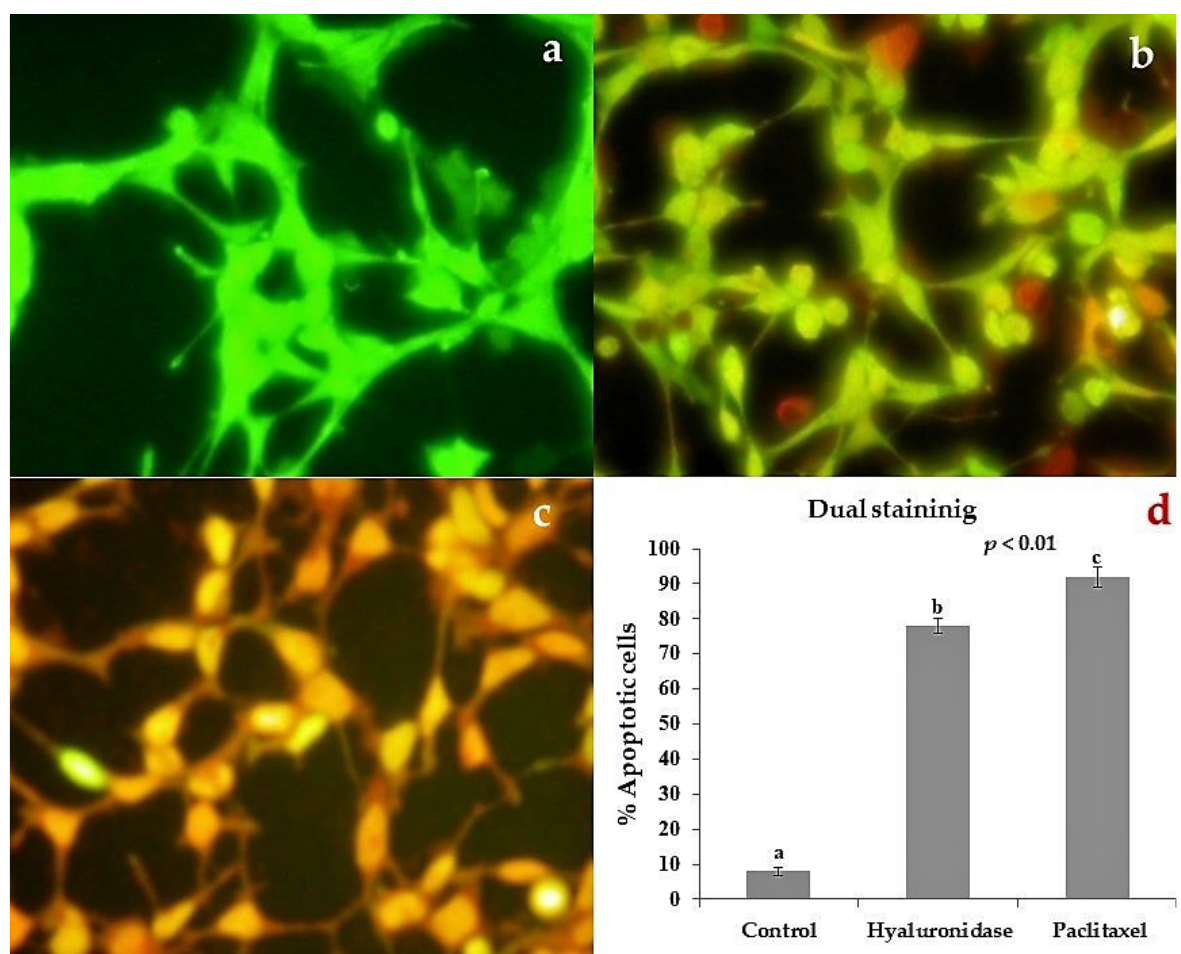
Figure 11. Microscopic image showing apoptotic morphological changes, as assessed by EtBr and AO staining. ( a ) control cells showed evenly distributed acridine orange stain (green fluorescence) with no morphological changes, ( b ) Staphylococcal hyaluronidase treated cells. The apoptotic features with condensed or fragmented chromatin were observed in Staphylococcal hyaluronidase treated MCF- 7 cells, ( c ) Standard Paclitaxel treated cells showed apoptotic morphological features and cell damage. ( d ) Effect of Staphylococcal hyaluronidase on apoptosis (%) in MCF - 7 cells. Values are given as mean ± S.D. of six experiments in each group. Values not sharing a common marking (a, b, c) differ significantly at p ≤ 0.05 .